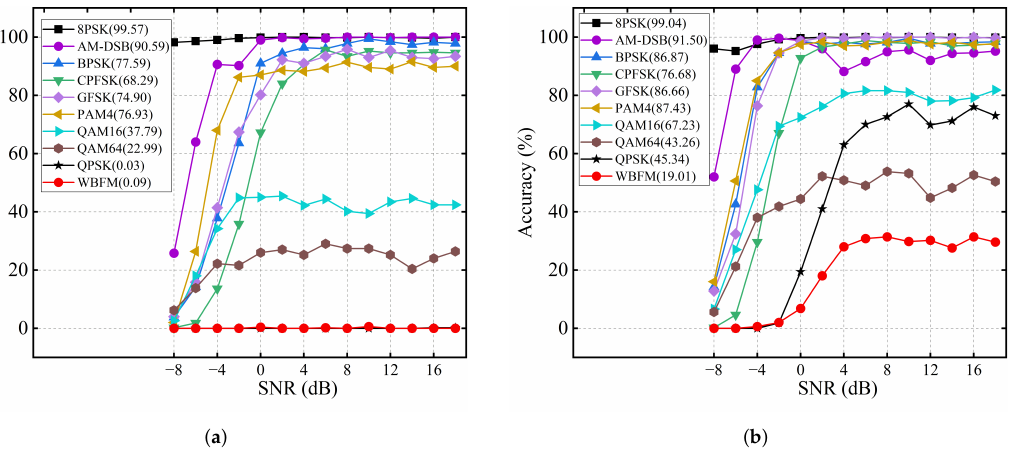
Figure 10. Recognition accuracy (%) of the ( a ) SE-MSFN and ( b ) SE-MSFN with SigAugment-R on the 2016A-50 dataset for each modulation class, with the values in parentheses in the legend representing the average recognition accuracy for each class across all